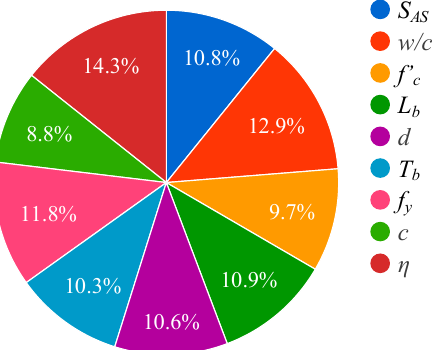
Figure 15. Influencing parameters.